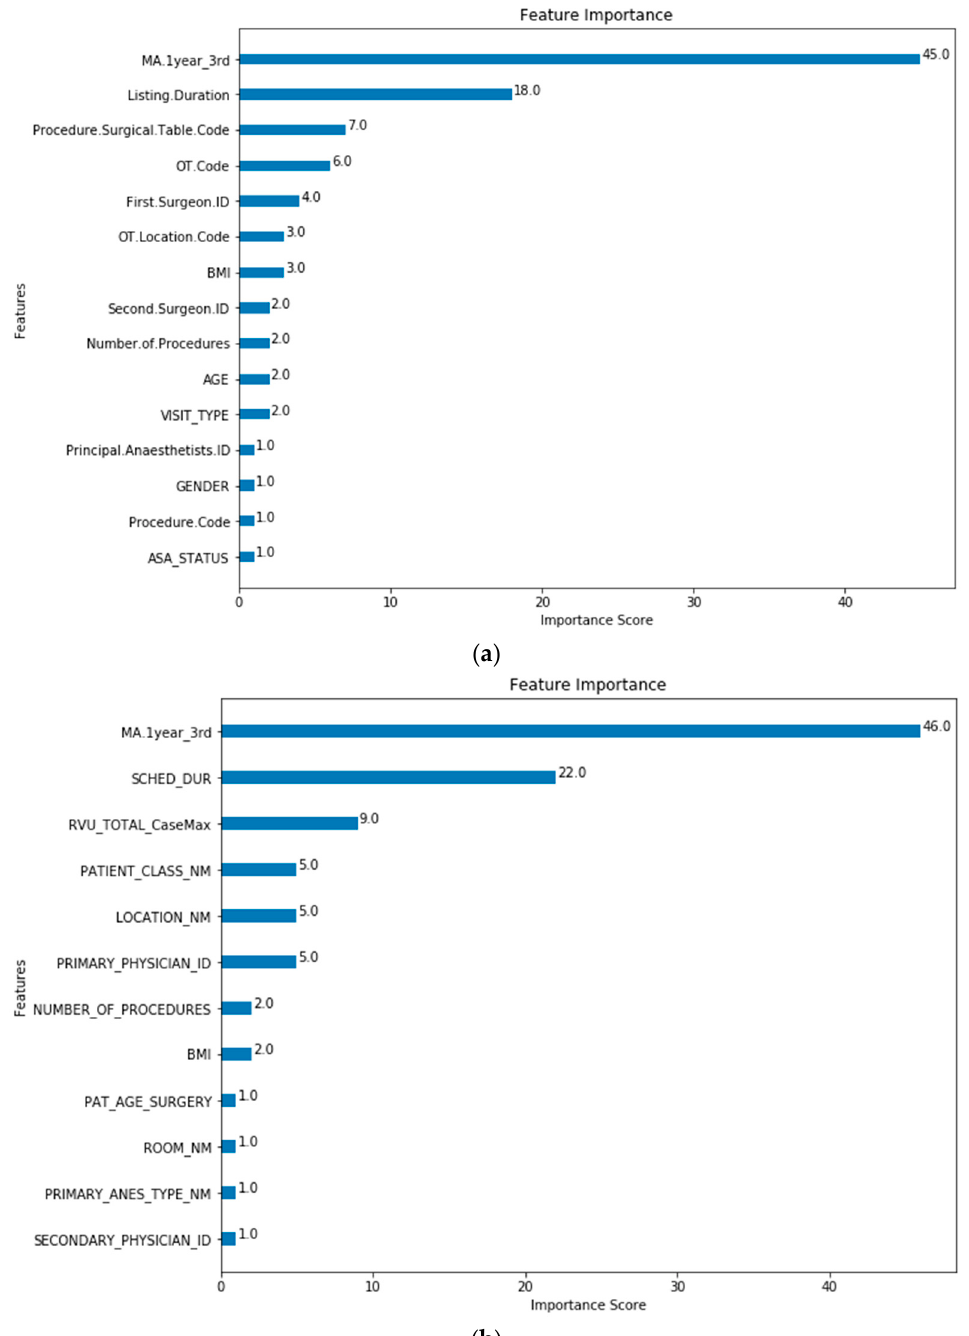
Figure 4. Model 5 Feature Importance for ( a ) SH-1 (Procedure.Surgical.Table.Code is “Procedure Code”; ( b ) SH-2 (RVU_TOTAL_CaseMax is “CPT List”). (Note: Refer to Table 1 for feature mapping between SH-1 and SH-2).